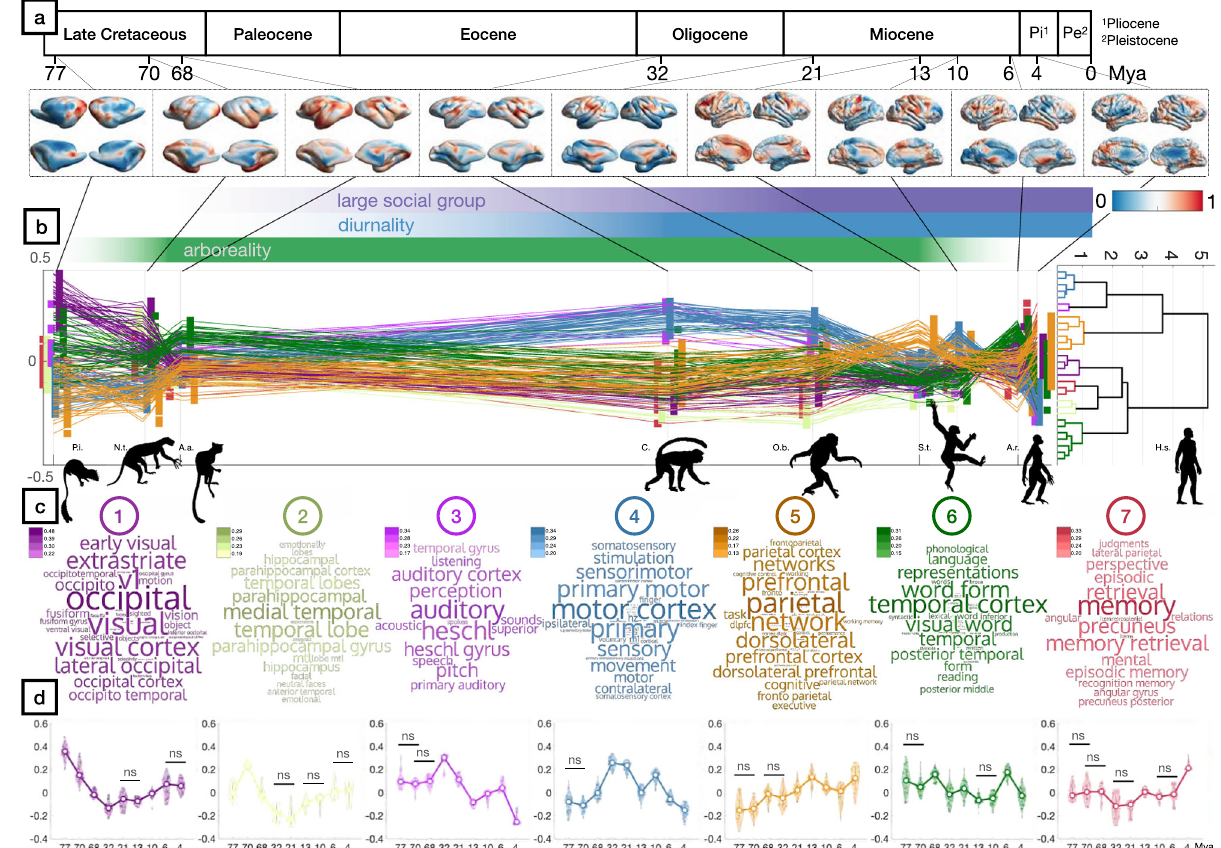
Fig. 7 | Estimated sequence of local cortical expansion from the last common ancestor of rodents and primates to Homo . a Consecutive expansion maps between the cortical surfaces are obtained from ancestral state reconstruction of all ancestors of Homo until the LCA with Glires. b Decoding these expansion maps as correlations with statistical maps of human cortical function 54 and retaining the 1% most highest correlated maps at each time-point allows to perform ( c ) hier- archical clustering of the sequential correlation of expansion patterns in the deep ancestral human lineage (Supplementary Data 7a). d This reveals a decomposition ofevolutionarycorticalsurfaceexpansionthatcanbeapproximatedasasequence of steps (Supplementary Data 7b), starting with the expansion of primary visual, auditory and motor regions in the Cretaceous up until the Oligocene, followed by the expansion of higher order association areas in the Miocene, Pliocene and